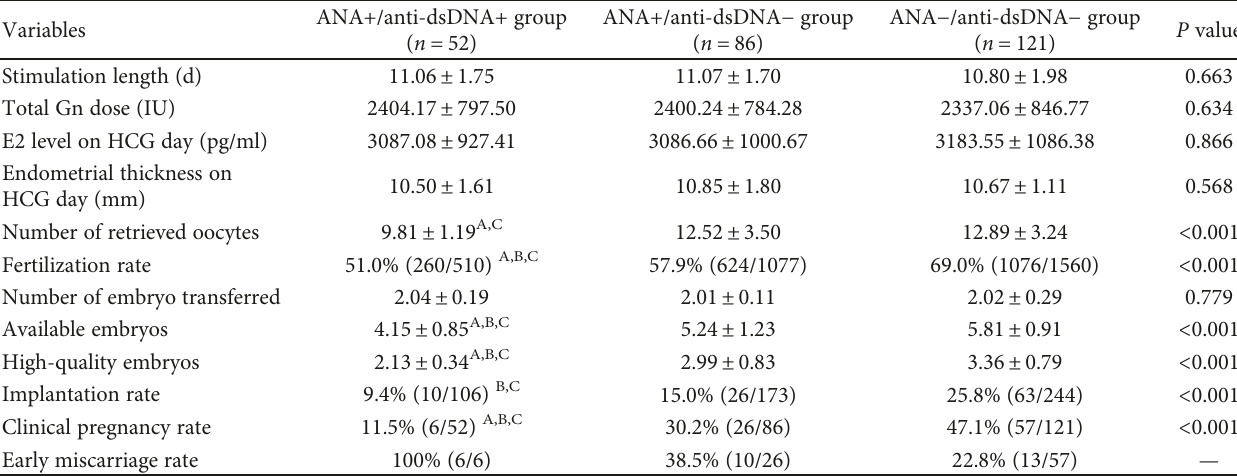
Table 2: Comparison of COS and IVF outcomes among the three groups.